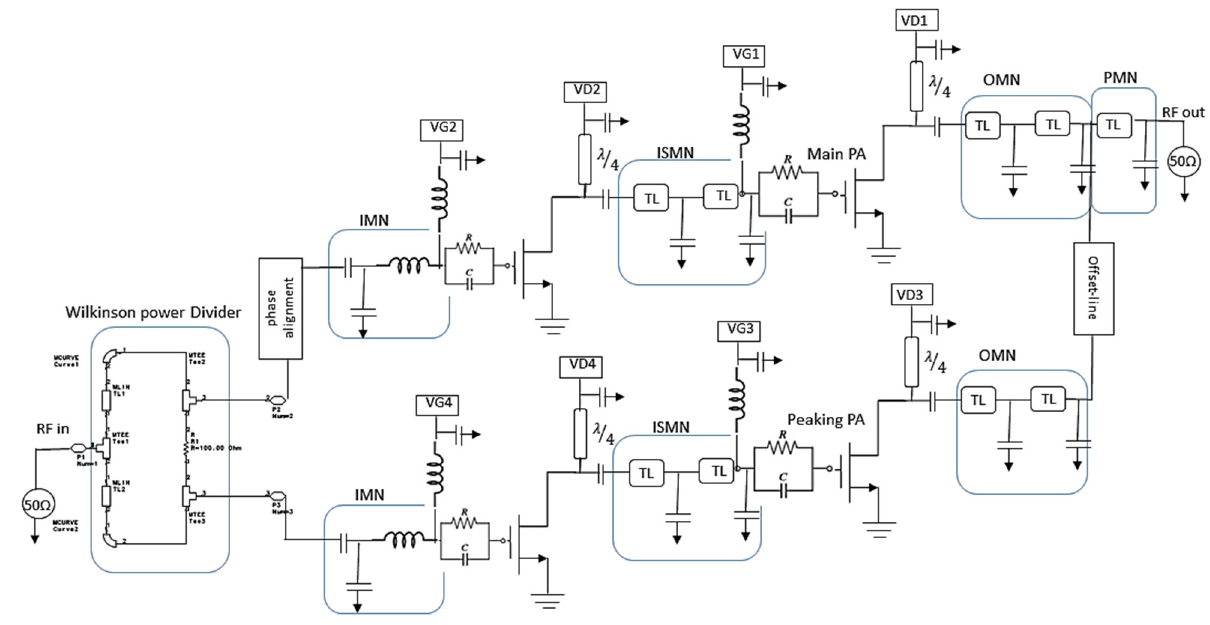
Figure 5. Detailed schematic of the 1 W-DPA.